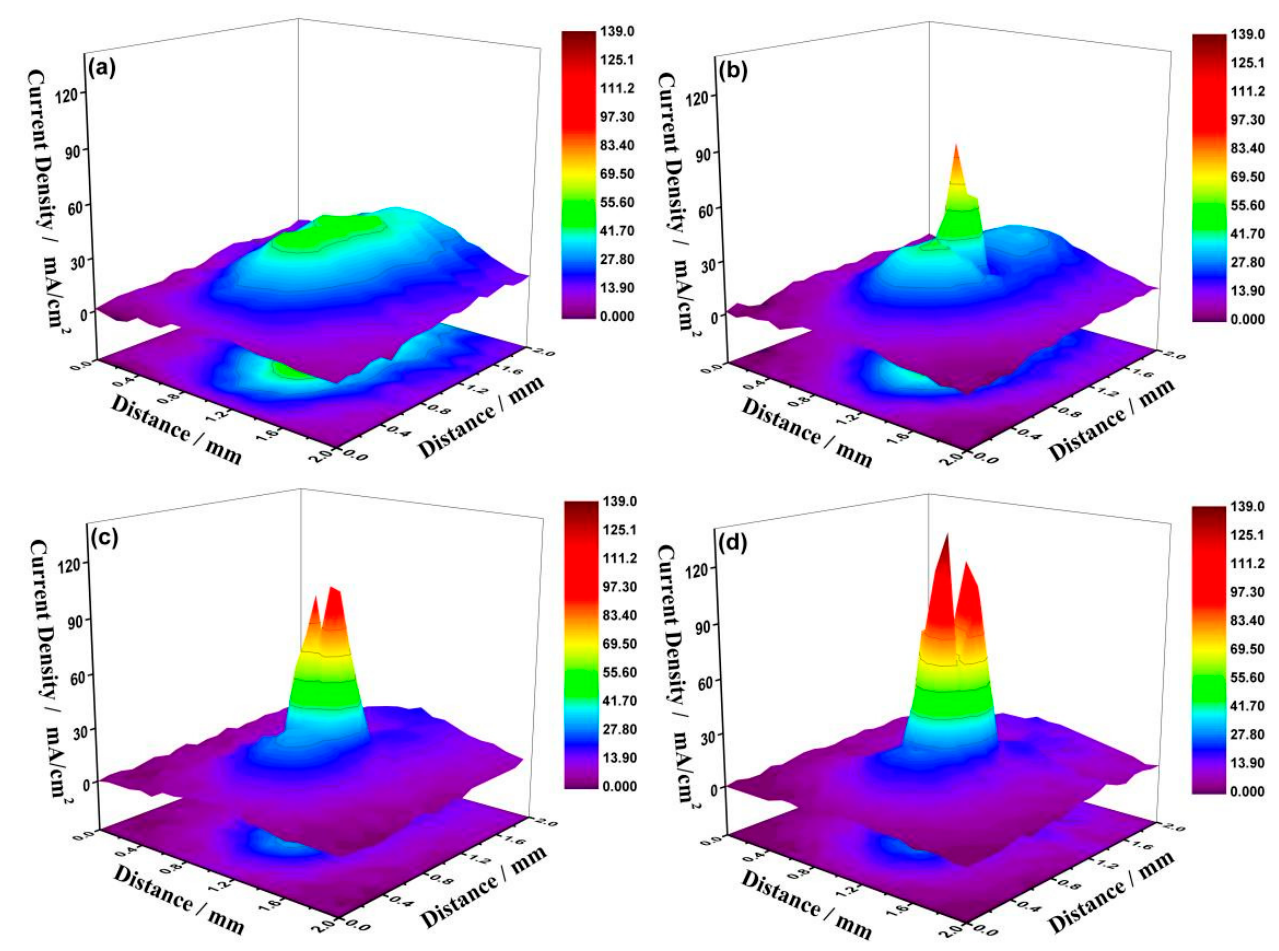
Figure 11. Effect of the immersion time on in situ SVET images of boro-austempered steel in 0.5% NaCl solution: ( a ) 0.5 h; ( b ) 1.5 h; ( c ) 2.5 h; ( d ) 3.5 h.